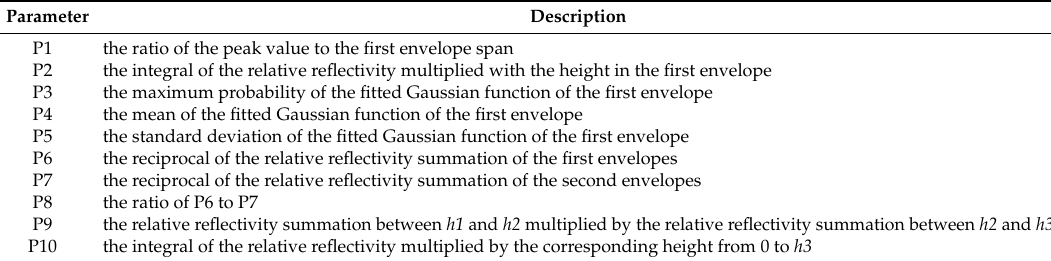
Figure 4. The schematic view of the stand vertical backscatter distribution. Table 3. Parameters of parameterizing average relative